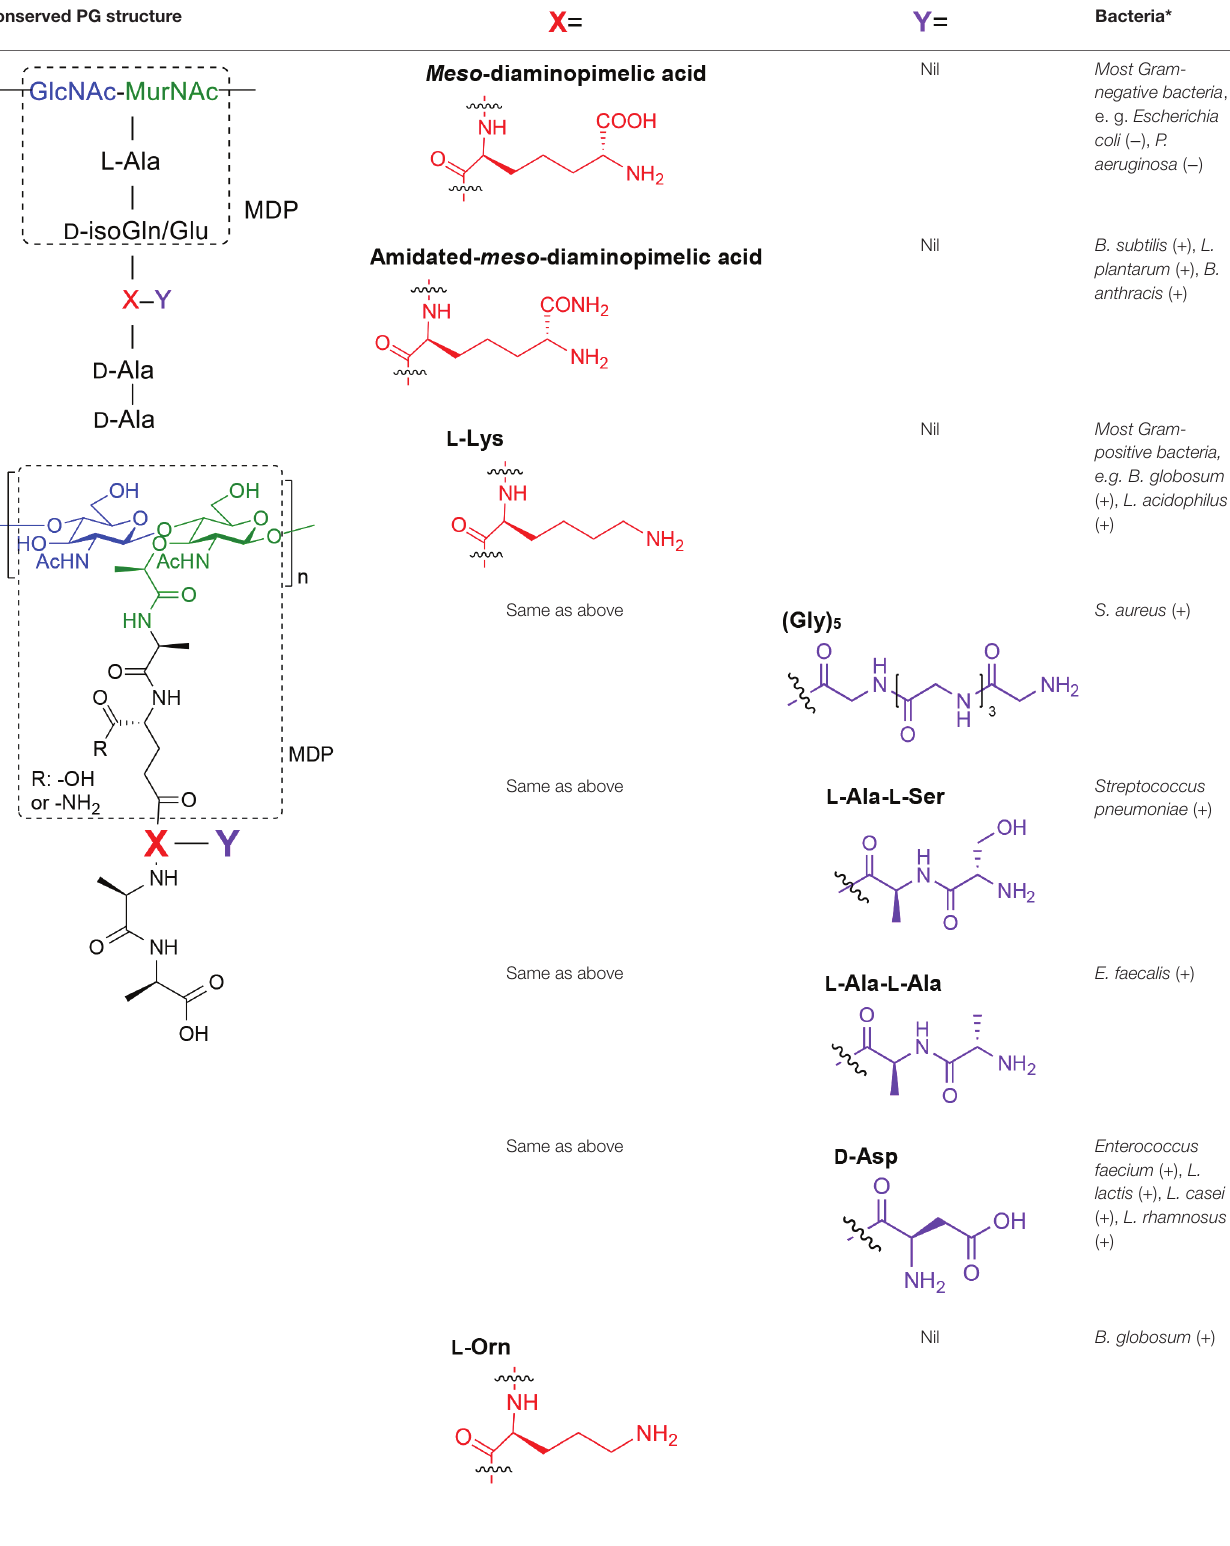
TABLE 1 | Summary of bacterial peptidoglycan compositions. Conserved PG